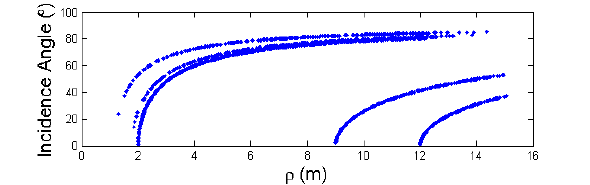
Figure 3: Incidence angle of the laser as a function of range